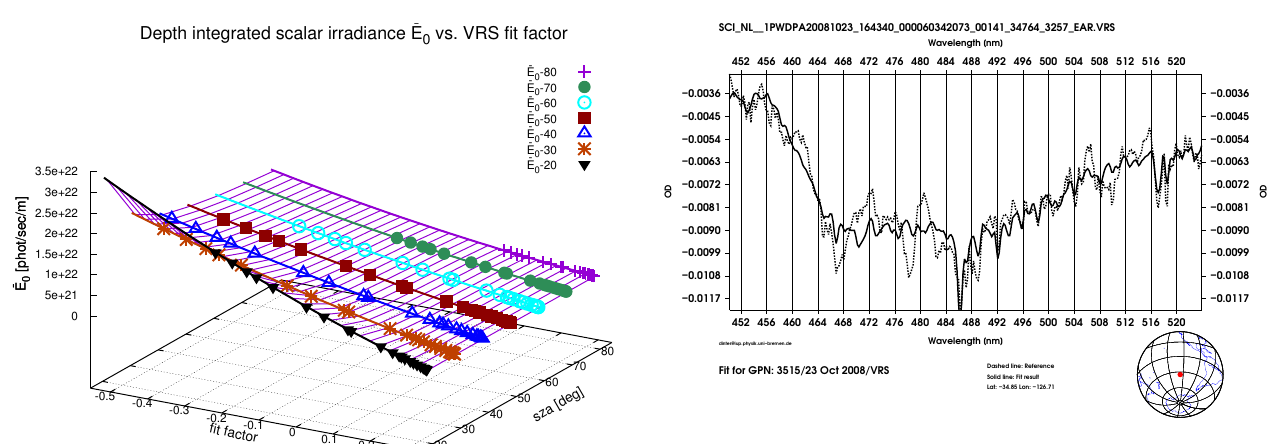
Figure 11. Example of the optical density (OD) of a VRS weighting function fit at an oligotrophic site over the South Pacific on 23 Octo- ber 2008. The solid line is the scaled VRS weighting function from Fig. 5 and the dashed line is the measurement, where all compo- nents are subtracted besides